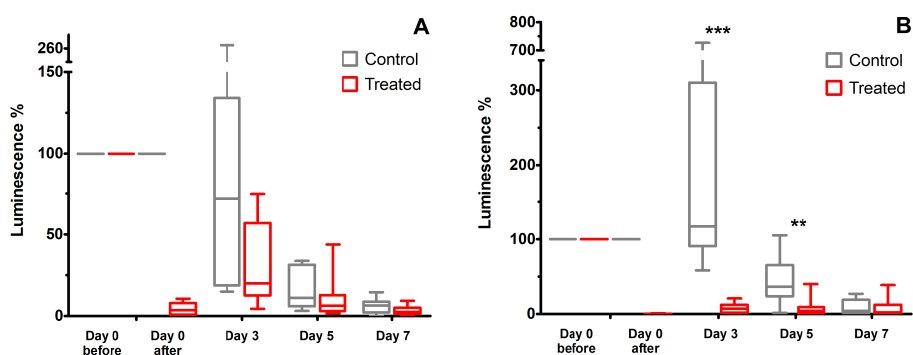
Figure 6. The luminescence of the ROI after the treatment using 1.8 kV protocol ( A ) and 3 kV protocol ( B ). All the data were normalized to the CTRL group. Asterisks: ** p ≤ 0.01; *** p ≤ 0.001.